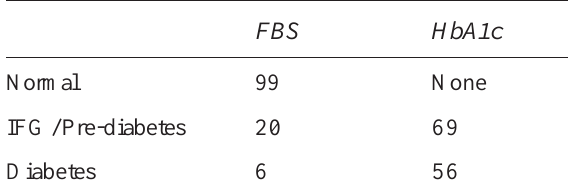
Table 2. Number of patients in different